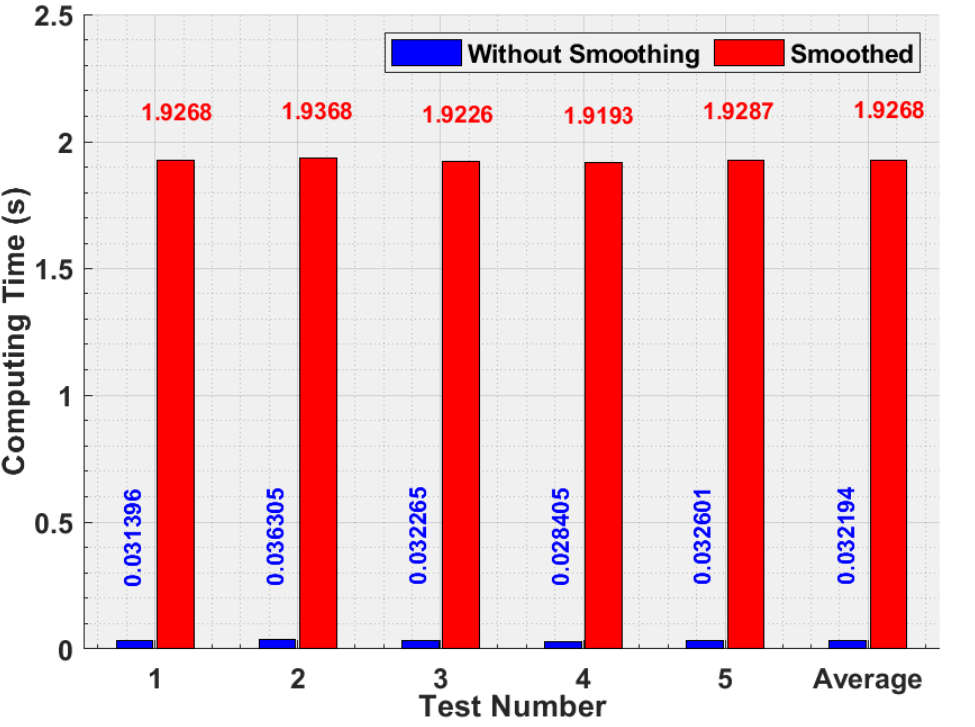
Figure 12. Comparison of the computation time used for the generation of original and smoothed trajectories in 3D for a swarm of 5